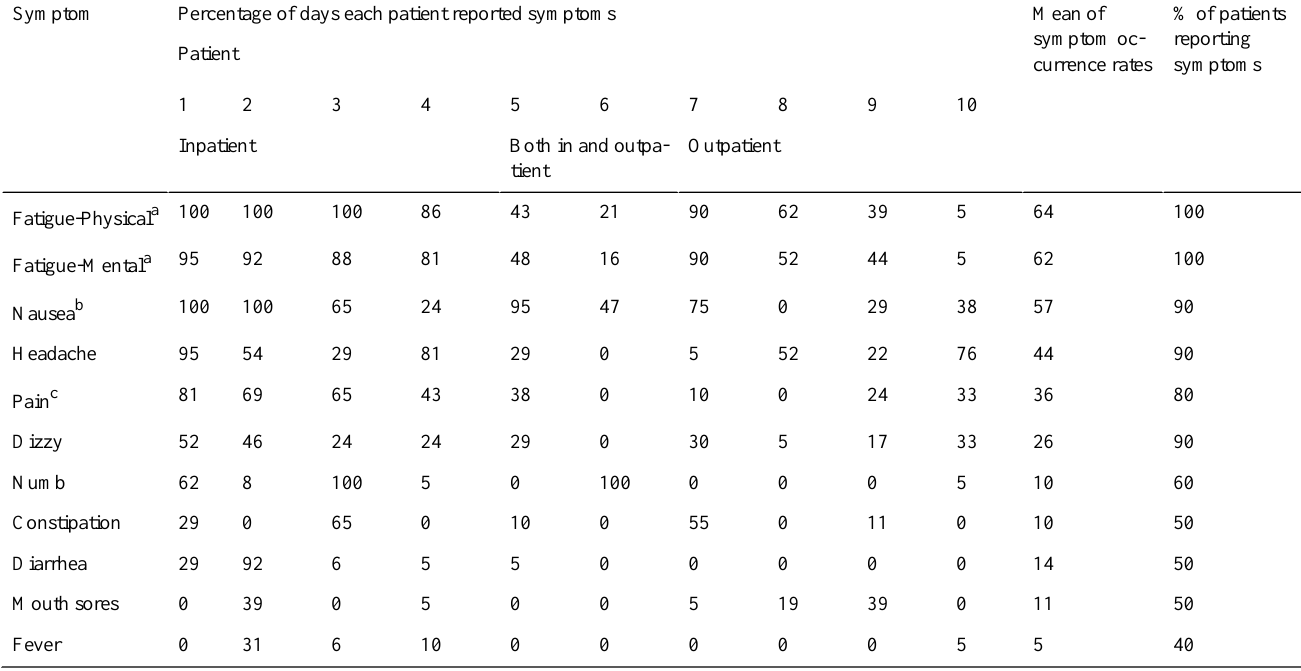
Table 3. Patients’reports of physical